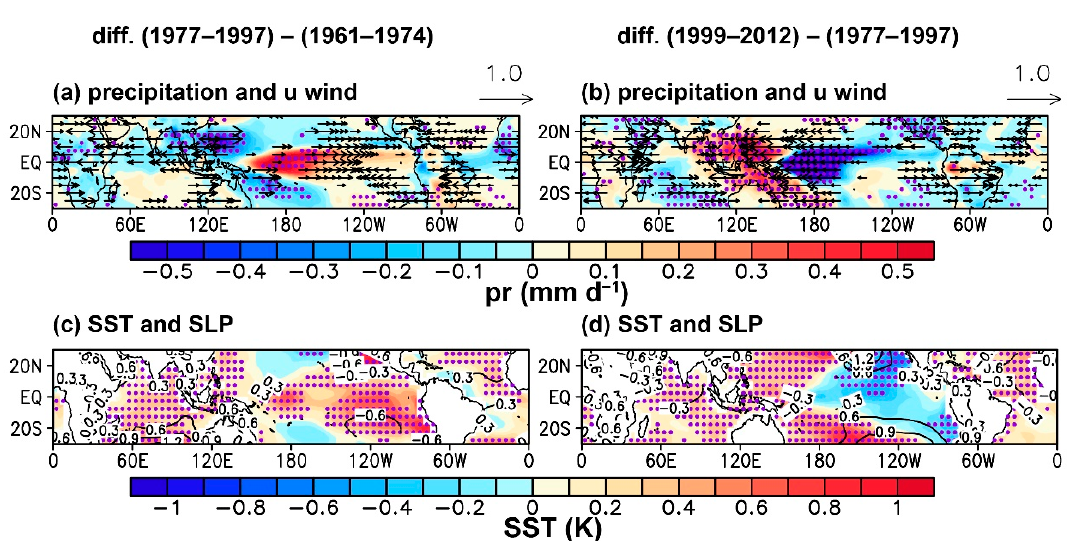
Figure 7. Differences in the precipitation (shading in ( a ); mm d − 1 ), zonal winds of zonal circulation at 1000 hPa (vectors in ( a ); m s − 1 ), sea surface temperature (SST) (shading in ( c ); K), and SLP (contours in ( c ); hPa) at low latitudes (30° S–30° N) between the periods 1961–1974 and 1977–1997. ( b , d ) are the same as ( a , c ) but show the differences between the periods 1977–1997 and 1999–2012. The vectors (contours) are plotted only for regions with zonal wind (SLP) changes that are statistically significant at the 5% confidence level. The changes in precipitation and SST that are statistically significant at the 5% confidence level are dotted in purple. The black solid (dashed) lines represent the positive (negative) changes in the SLP. The arrows shown in the top right corner of (a) and (b) are the reference vectors.